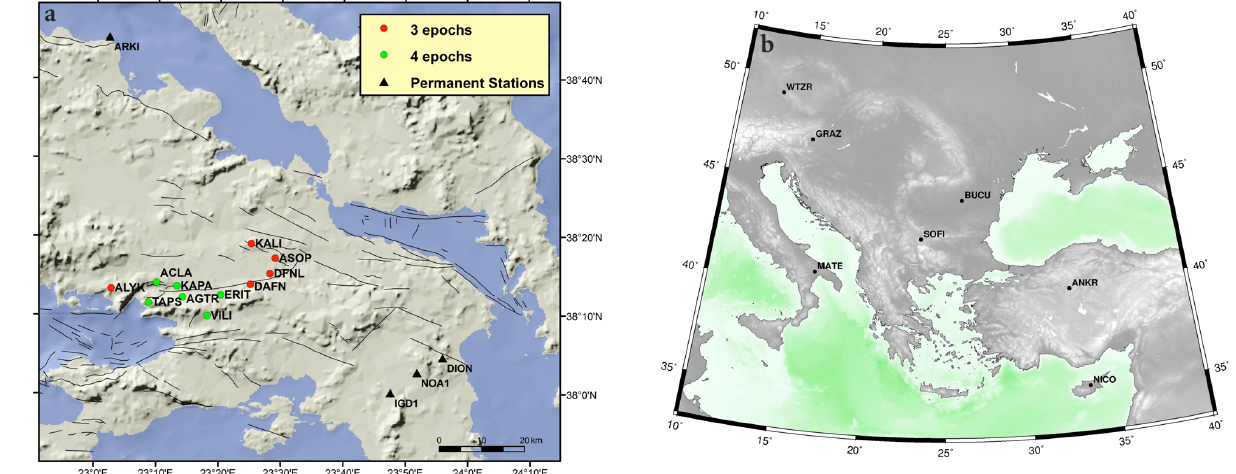
Figure 3. (a) Relief map showing the geodetic network of Kaparelli Area. Station ARKI, NOA1, IGD1 and DION are the permanent geo- detic GPS stations near the area of interest that they have been included to the calculation in order to accomplish the realization of the ref- erence frame (b). Map of Europe showing location of stations used to align the GPS velocities to ITRF2005.